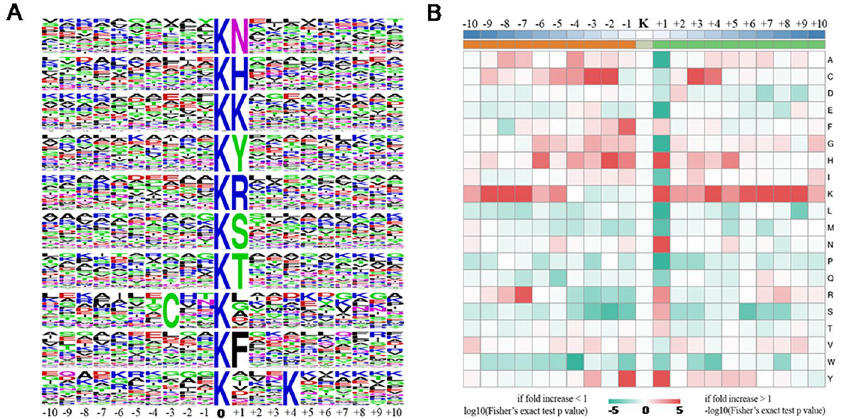
Figure 2. Motif analysis of identified Kac sites in C. chloroleuca 67–1. ( A ) Kac motifs and conservation of Kac sites. The size of each letter corresponds to the frequency of the amino acid residues in a given position. ( B ) Heatmap of the amino acid composition of Kac